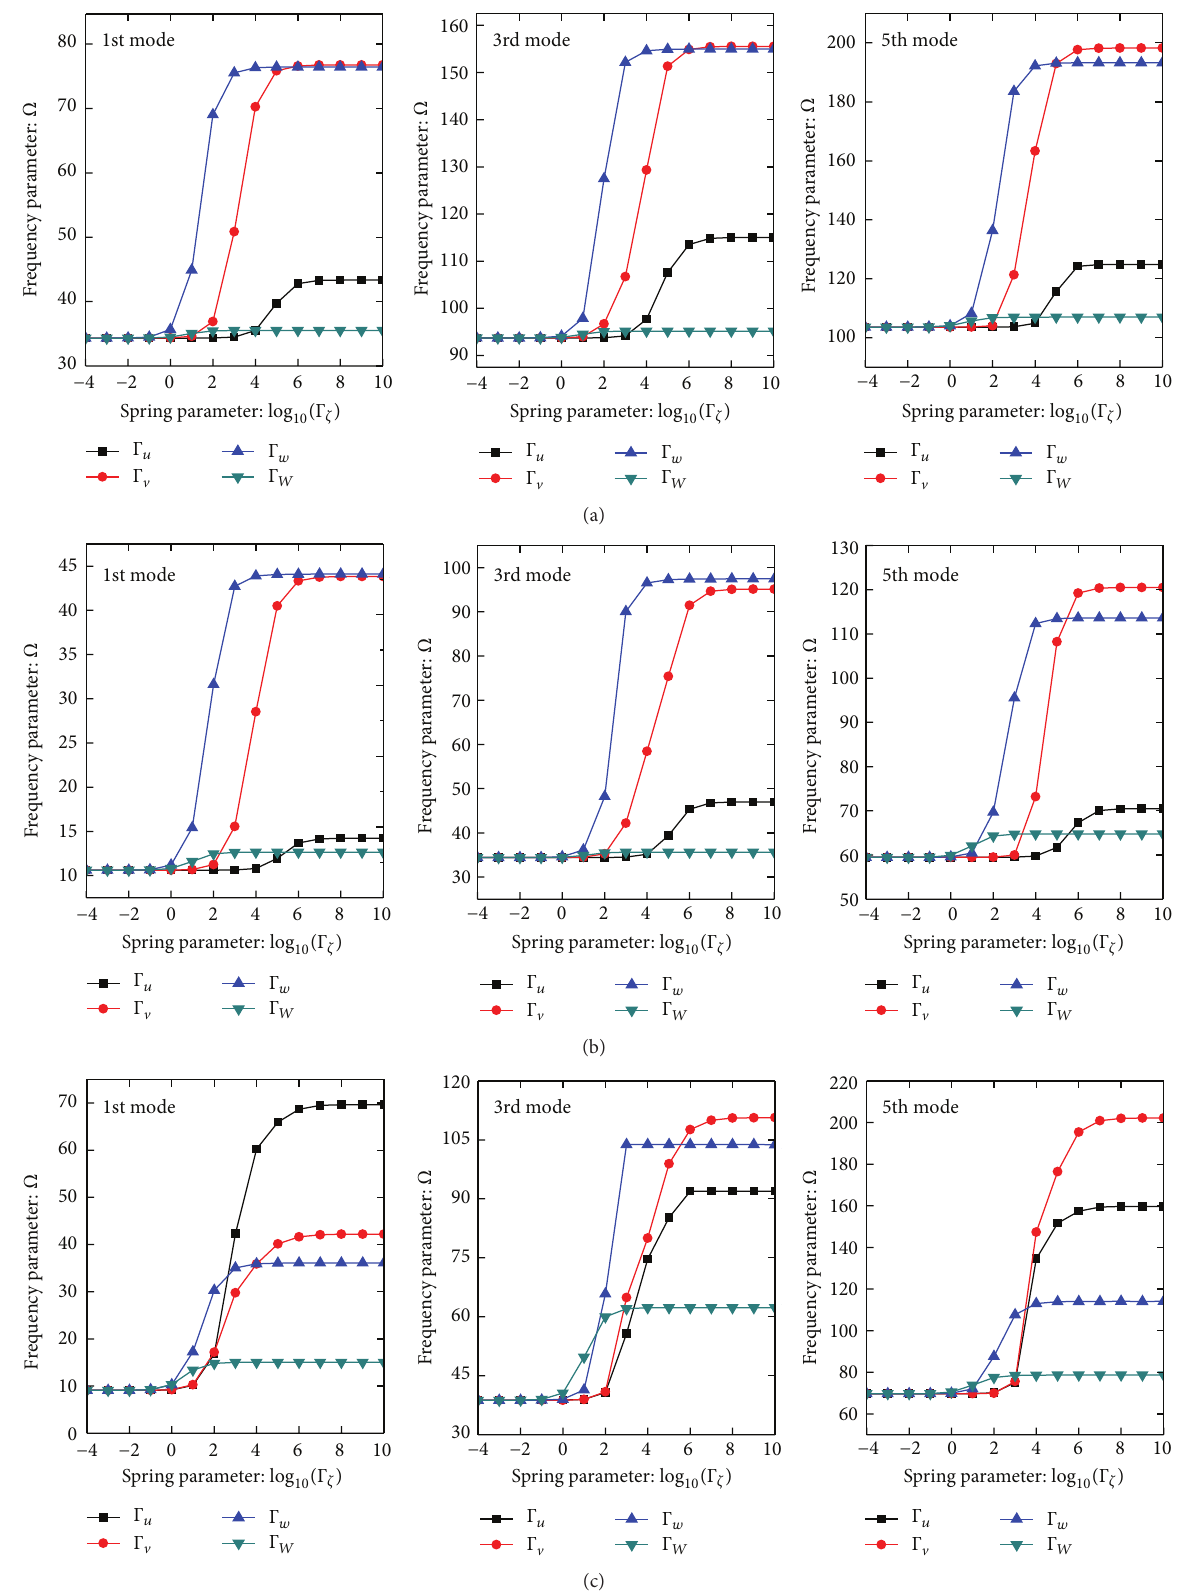
Figure 5: Effects of boundary spring stiffness on the 1st, 3rd, and 5th frequency parameters Ω = 𝜔𝐿 2 √𝜌ℎ/𝐷 of open shells with C-F-E I